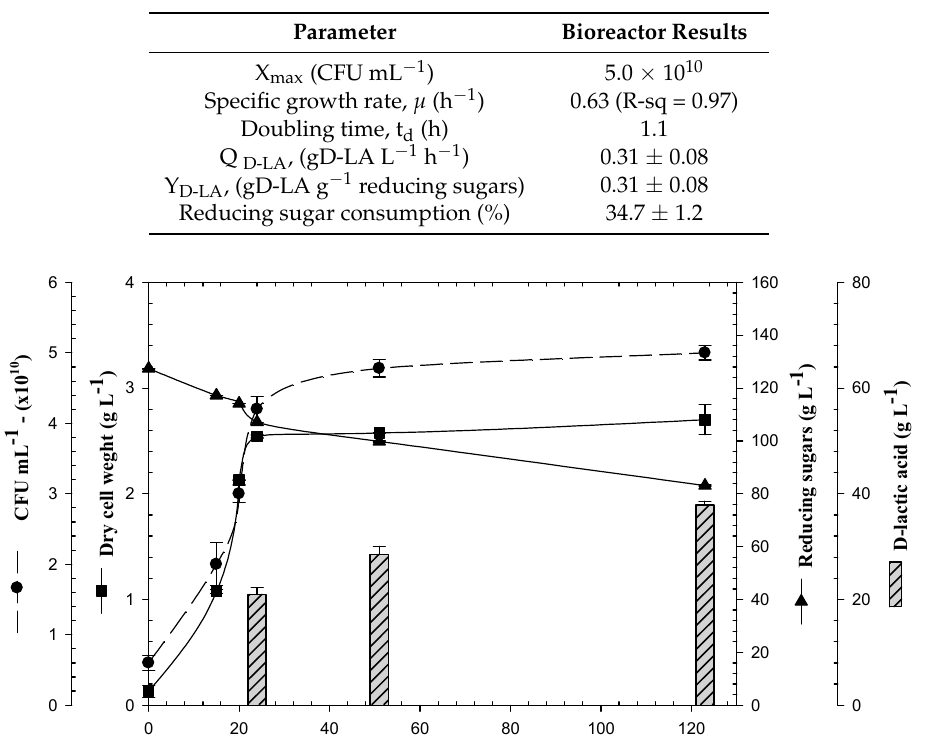
Table 2. Batch bioreactor kinetic results with 120 g L − 1 of initial reducing sugars.